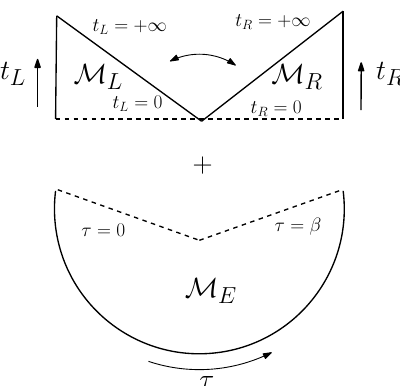
Figure 3 . The mixed signature bulk spacetime containing two Lorentzian regions, with future horizons identi(cid:12)ed and one Euclidean black hole (cid:12)nite time slices. Notice that in order to simplify the drawing we (cid:13)ipped the left segment with respect to the way it appears in (cid:12)gure 2, so that the left time increases now upwards. hole are e(cid:11)ectively identi(cid:12)ed with one another. In this way, the bulk spacetime